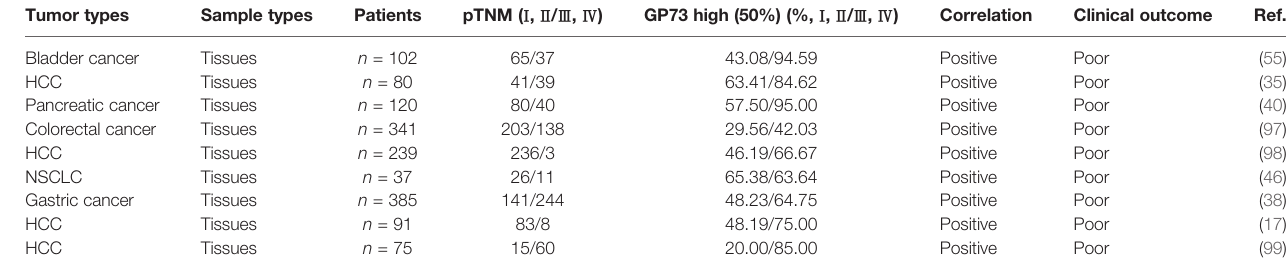
TABLE 3 | GP73 expression and its correlation with cancer in fi ltration.